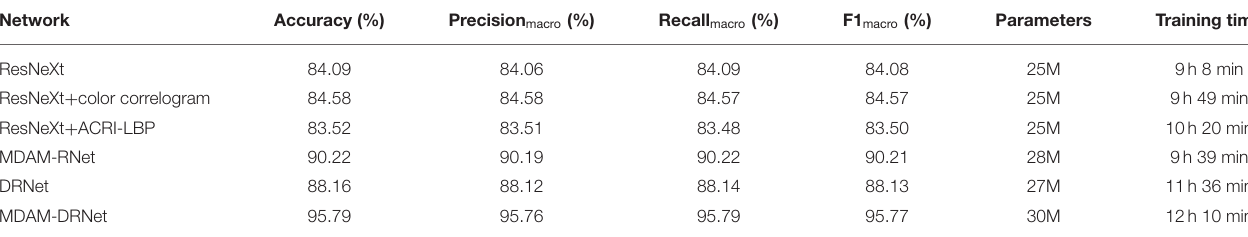
TABLE 7 | Each model corresponds to the recognition accuracy of each strawberry leaf